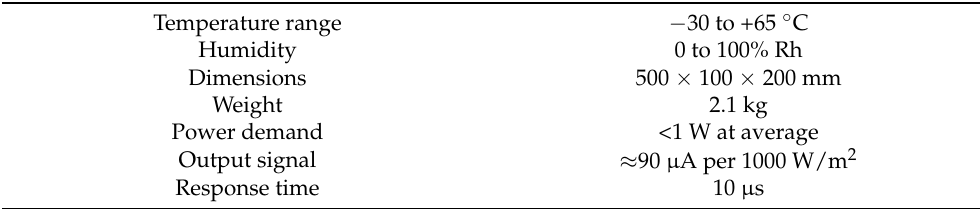
Figure 3. CSPC Twin-RSI installed at UET Peshawar. Table 2. Specifications of